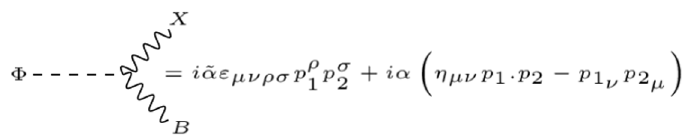
Figure 2 . Decay of Φ → XB before EWSB and Φ → Xγ ( Z ) after EWSB, which contributes to the freeze-in production of X . The vertex factor shown here is the one for Φ → XB